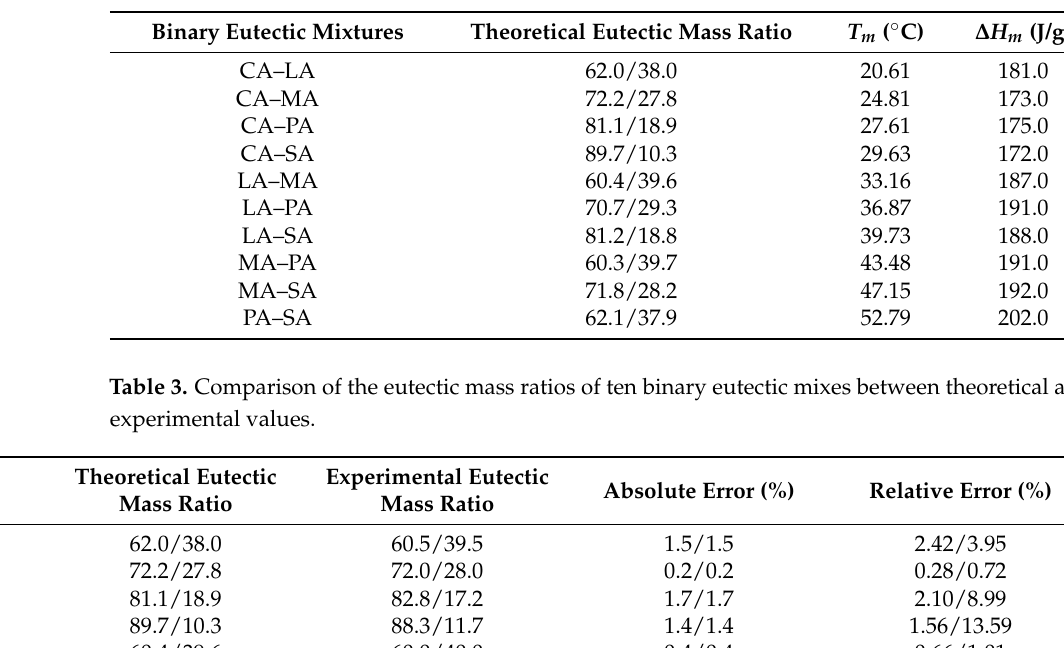
Table 2. Theoretical eutectic point of ten fatty acid binary eutectic mixtures. Binary Eutectic Mixtures